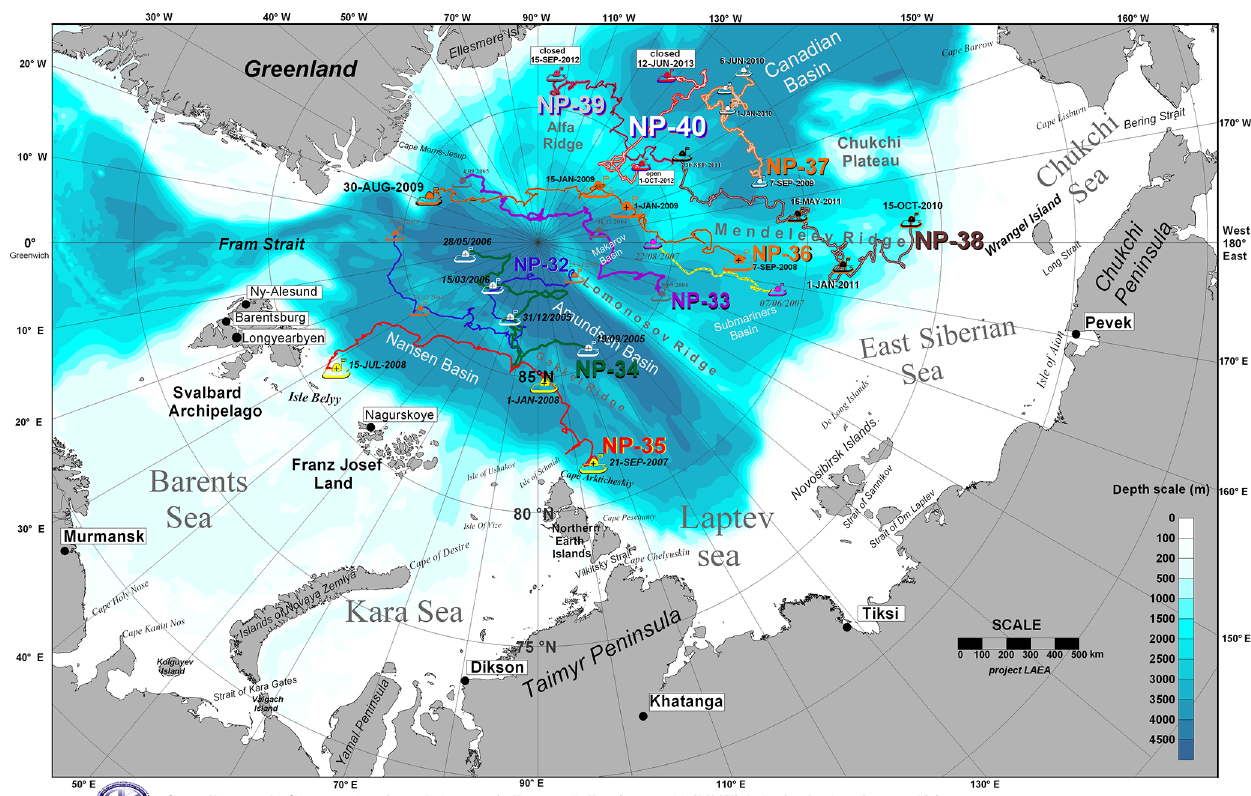
Figure 3. Trajectories of Russian “North Pole” drifting stations in the 21st